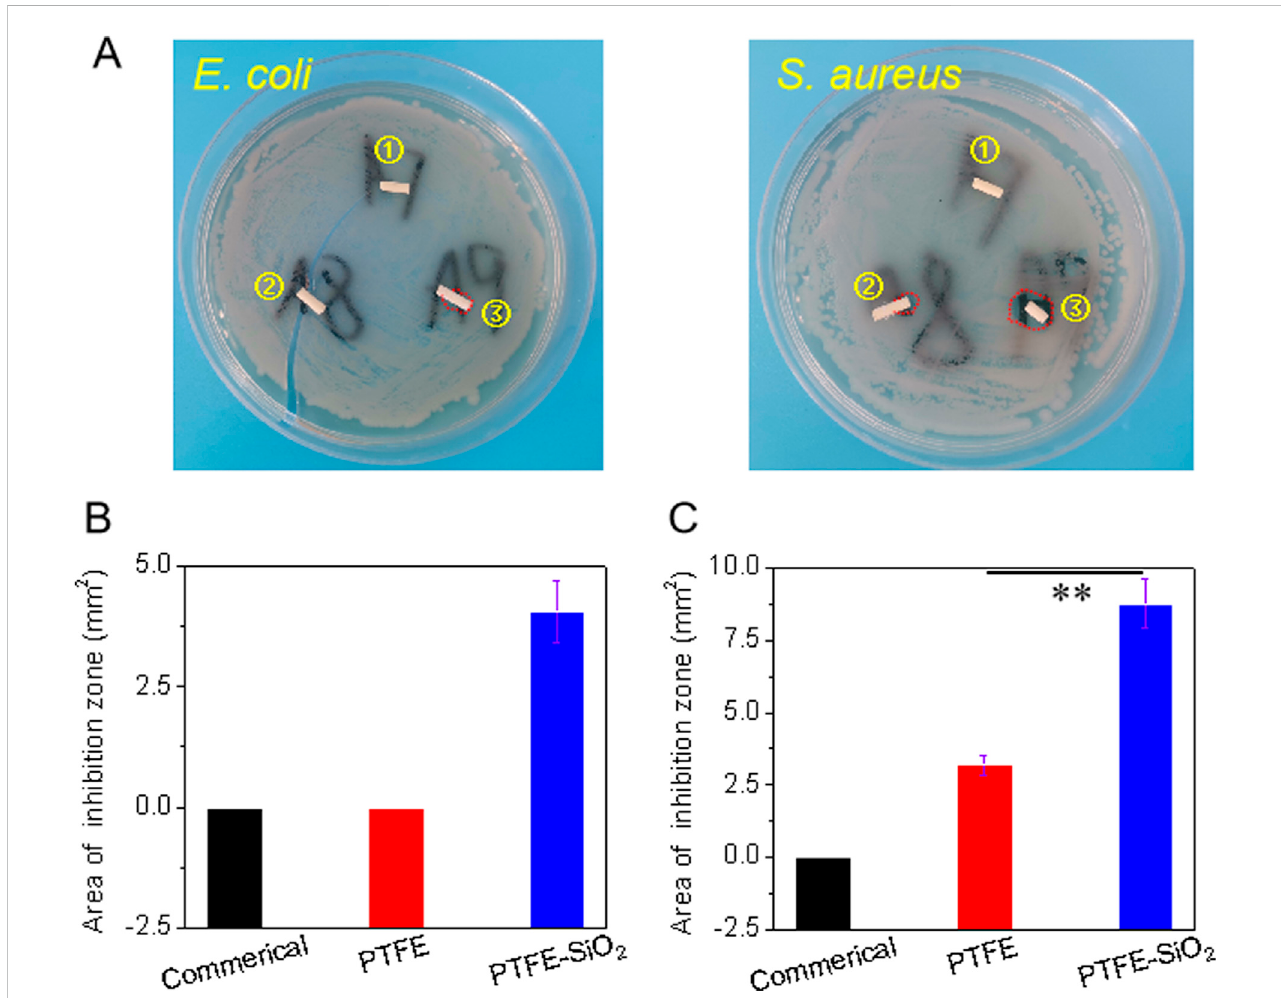
FIGURE 6 (A) Visual images of the antibacterial zone of catheter to Escherichia coli ( E. coli ) and Staphylococcus aureus ( S. aureus ) after incubation for 6 h. Spot ① , ② , and ③ represents commerical catheter, PTFE catheter, and PTFE-SiO 2 catheter, respectively; of commerical catheter, PTFE catheter, and PTFE-SiO 2 catheter, respectively; (B) and (C) Quanti fi ed antibacterial zone of commerical catheter, PTFE catheter, and PTFE-SiO 2 catheter after 6 h incubation with E. coli and S. aureus , respectively. ( n = 5, **p < 0.01